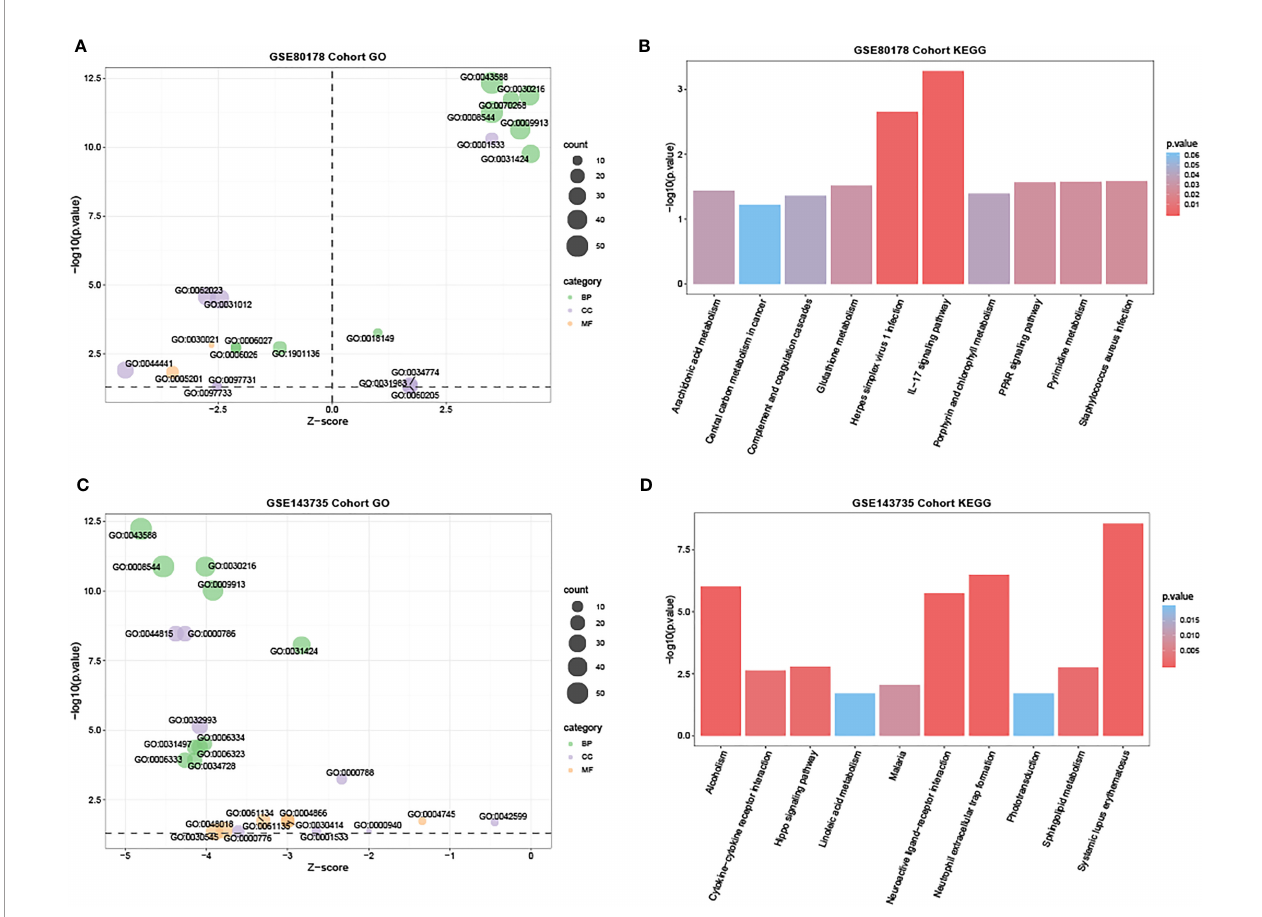
FIGURE 4 | GO and KEGG functional enrichment analysis in GSE80178 and GSE143735. (A) The bubble chart of the GO terms, including BP, MF, and CC, was signi fi cantly enriched in GSE80178. Green bubbles represent BP; purple bubbles represent MF; orange bubbles represent CC. (B) Histogram of the top 10 KEGG pathway enrichment in GSE80178. (C) Bubble chart of the GO terms, including BP, MF, and CC, was signi fi cantly enriched in GSE143735. The green bubble represents BP; the purple bubble represents MF; the orange bubble represents CC. (D) Histogram of the top 10 KEGG pathway enrichment in